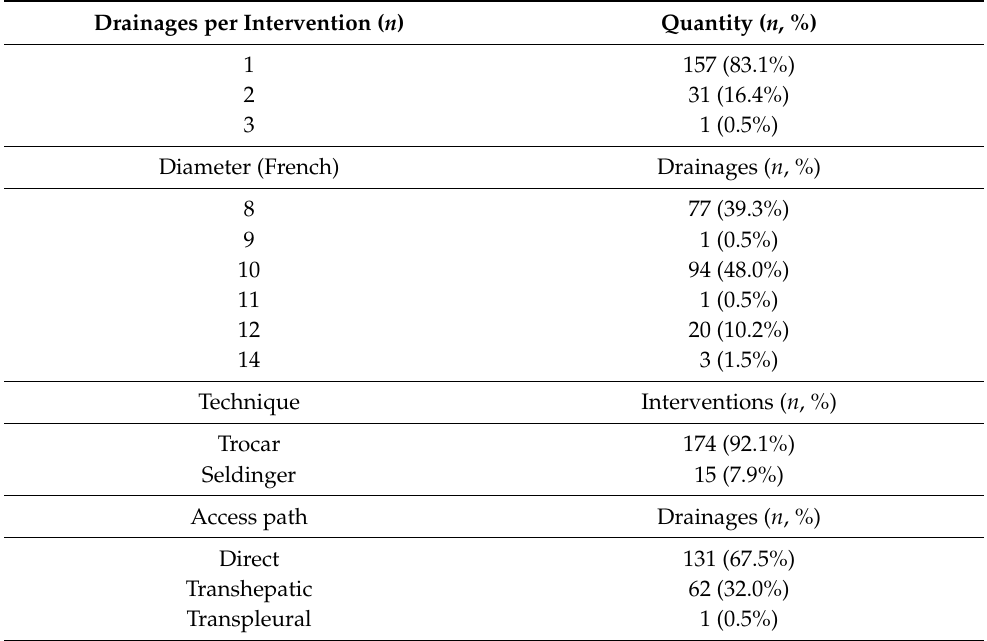
Table 2. Information on drainages and intervention